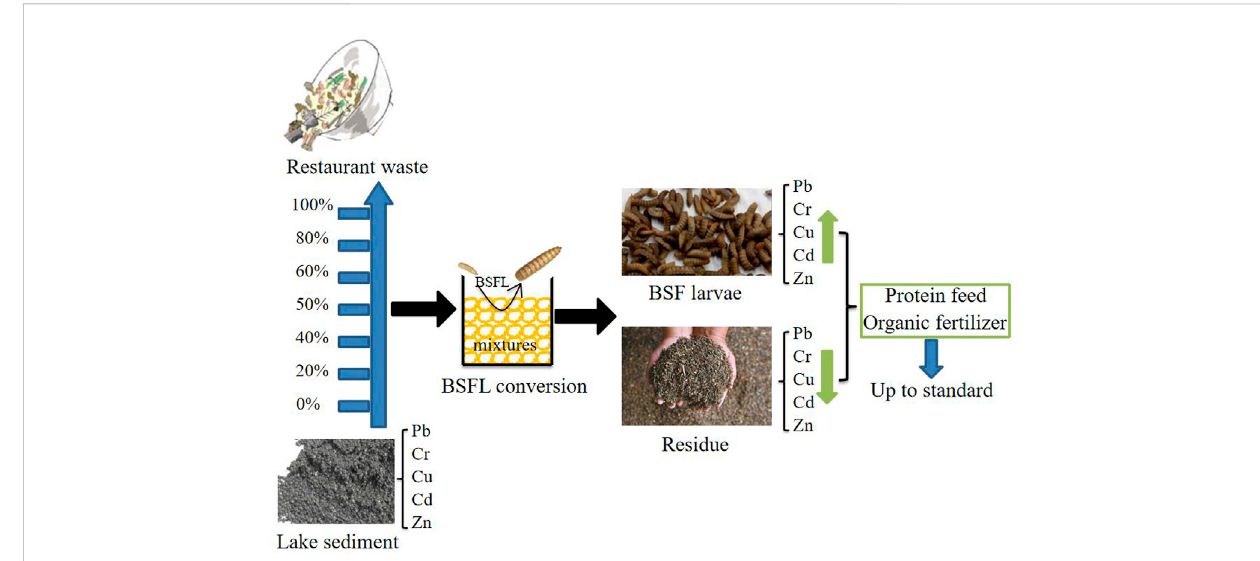
The experimental design of the conversion of lake sediment and restaurant waste by